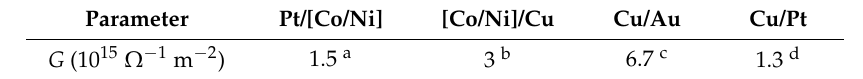
Table 2. Interfacial parameters for the spin diffusion modeling. G is the electrical conductance at the